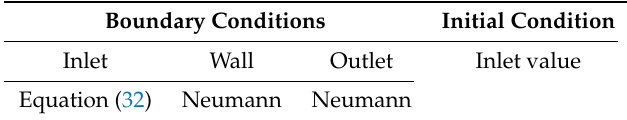
Table 7. Boundary conditions, initial conditions and divergence scheme corresponding m i